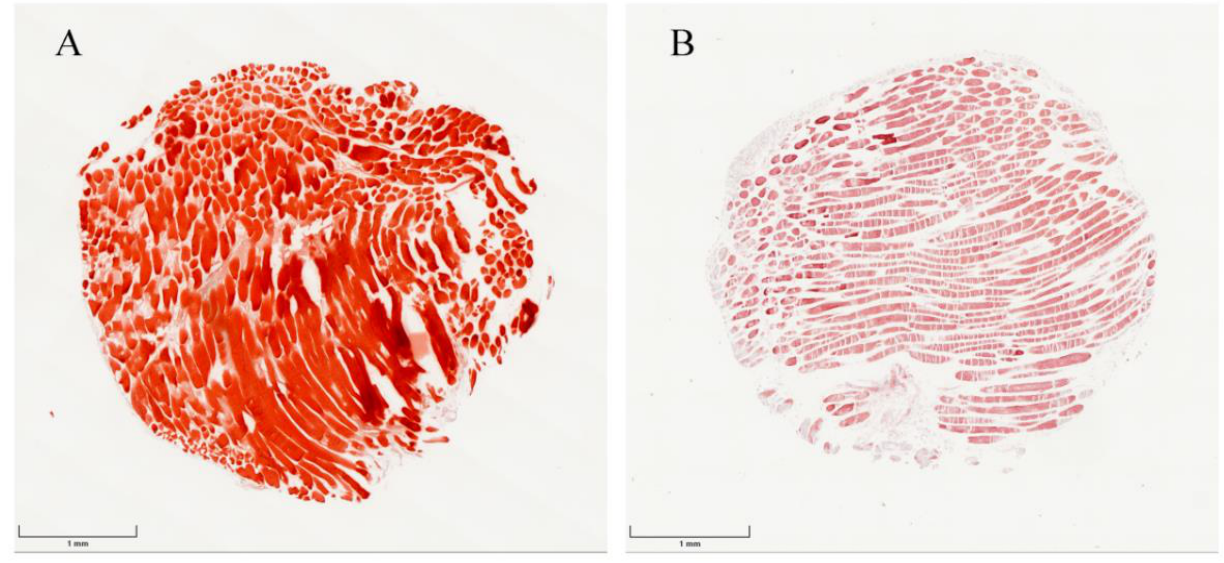
Figure 7. Alizarin red S stained 4 mm muscle/fascia tissue fragments: ( A ) Ad.hBMP-2-transduced muscle/fascia co-cultured together with the scaffold for 4 weeks; MO + Ad.hBMP-2 fascia group: calcium depositions were detected through the entire Ad.hBMP-2-transduced muscle/fascia tissue, which were stained a bright red color by Alizarin red S. ( B ) Untreated fresh muscle/fascia tissue: no calcification was observed in untreated muscle/fascia tissue. Scale bar = 1 mm.